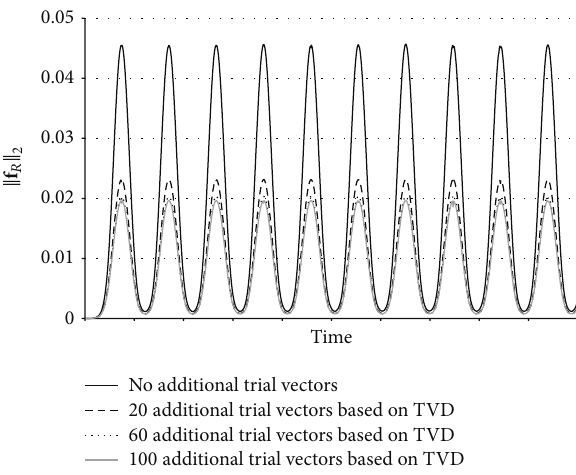
Figure18:TimeevolutionoftheEuclidiannormofthefrictionforce vector.